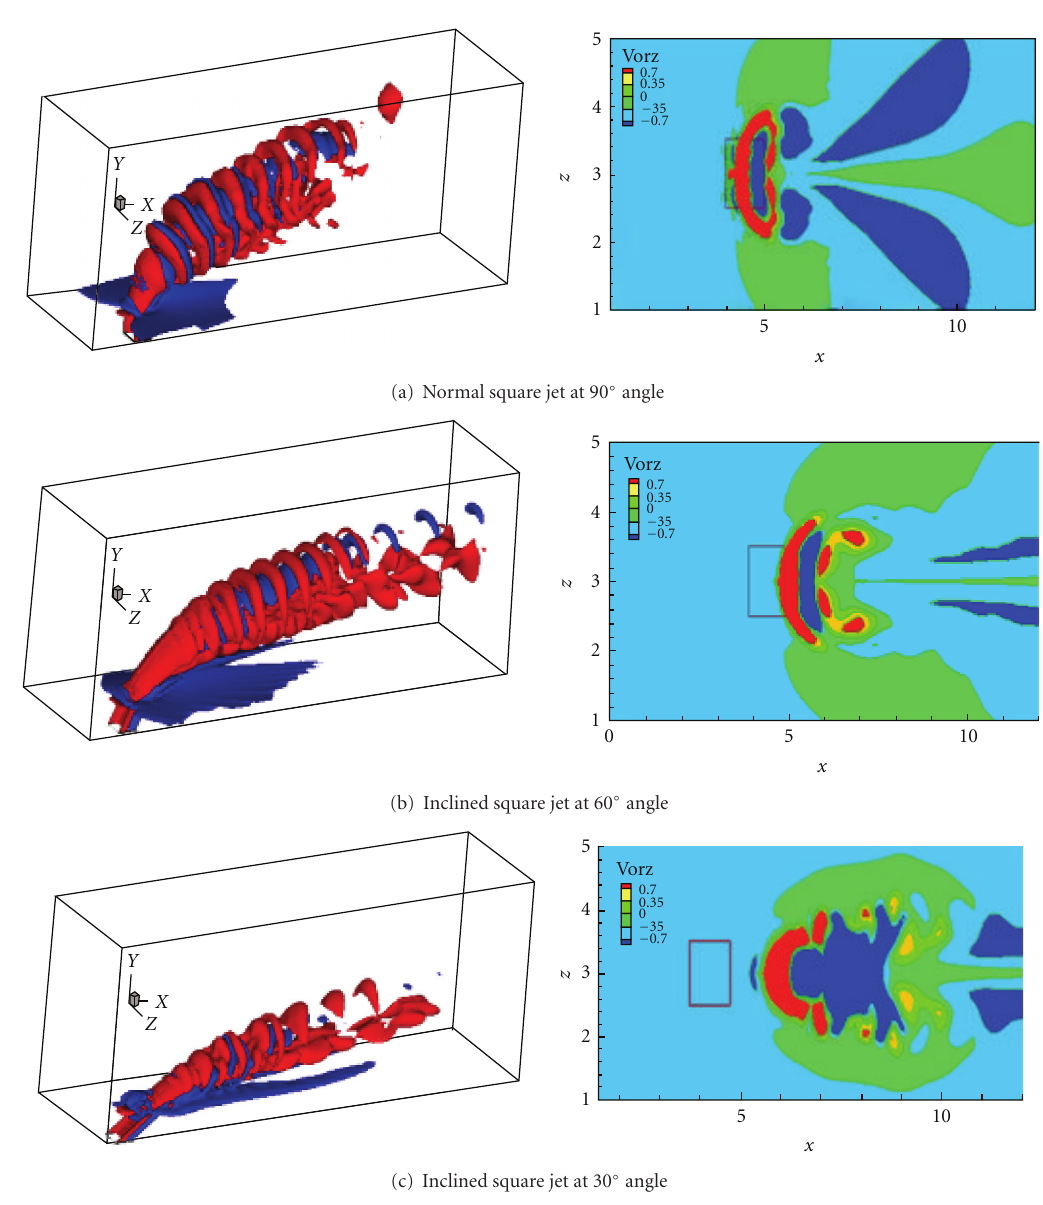
Figure 3: Simulated 3D isosurfaces of the spanwise vorticity ( ω z = 0 . 5 u 2 / D 2 , red: ω z = +0 . 5, blue: ω z = − 0 . 5) (left) and 2D contours of the spanwise vorticity at y = 1 . 2D